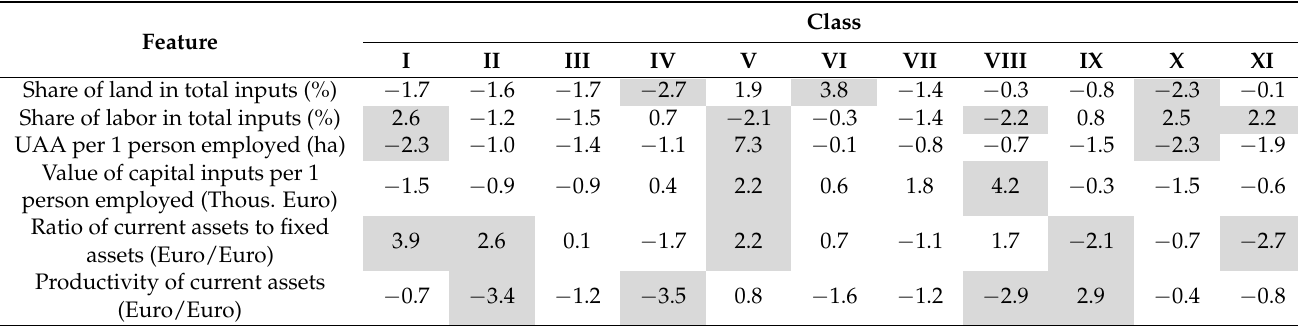
Table 5. Values of the measure of differences for mean metrics describing the production potential of the agricultural sector in the population of analyzed countries and in classes (Ward’s method).